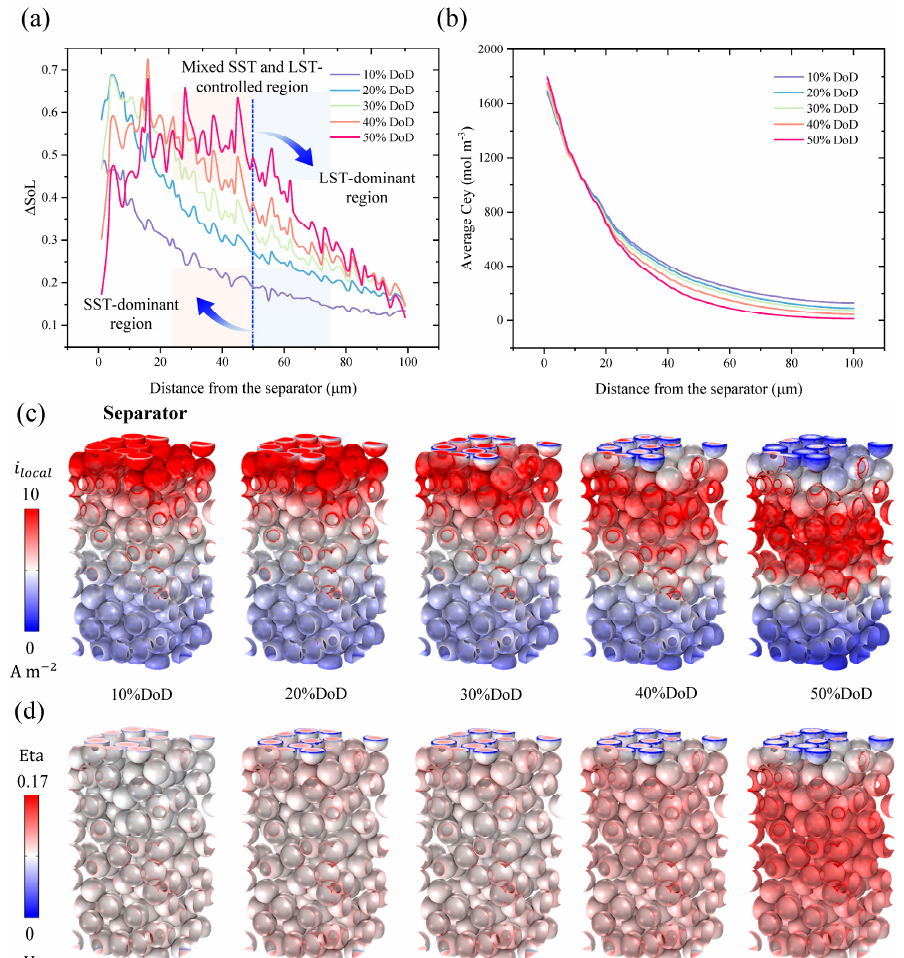
Figure 3. Analysis of mixed SST and LST-controlled region. The dynamic evolution of ( a ) ∆SoL distribution, ( b ) average lithium ions concentration distribution in the electrolyte, ( c ) the 3D local reaction current density distribution, and ( d ) the 3D local overpotential distribution. Note: the maximum DoD achievable for the homogeneous electrode with constant currents discharge at 5C (3.0V cut-off ) and 25 °C is 56%.